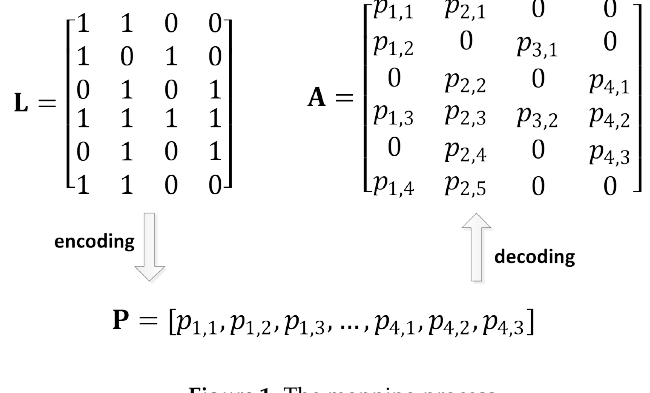
Figure 1. The mapping